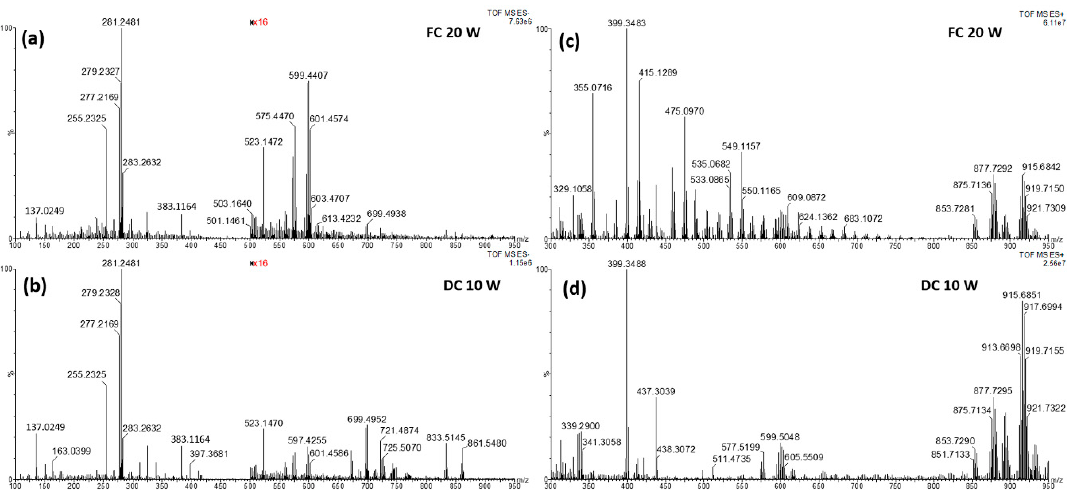
Figure 1. ( a ) Rapid evaporative-ionization mass spectrometry (REIMS) (-) spectrum over the mass range 100–950 m / z of a cut of K. africana , in forced-coagulation FC mode at a power of 20 W; ( b ) REIMS (-) spectrum over the mass range 100–950 m / z of a cut of K. africana , in dry-cut (DC) mode at a power of 10 W; ( c ) REIMS (+) spectrum over the mass range 300–950 m/z of a cut of K. africana , in FC mode at a power of 20 W; ( d ) REIMS (+) spectrum over the mass range 300–950 m/z of a cut of K. africana , in DC mode at a power of 10 W.